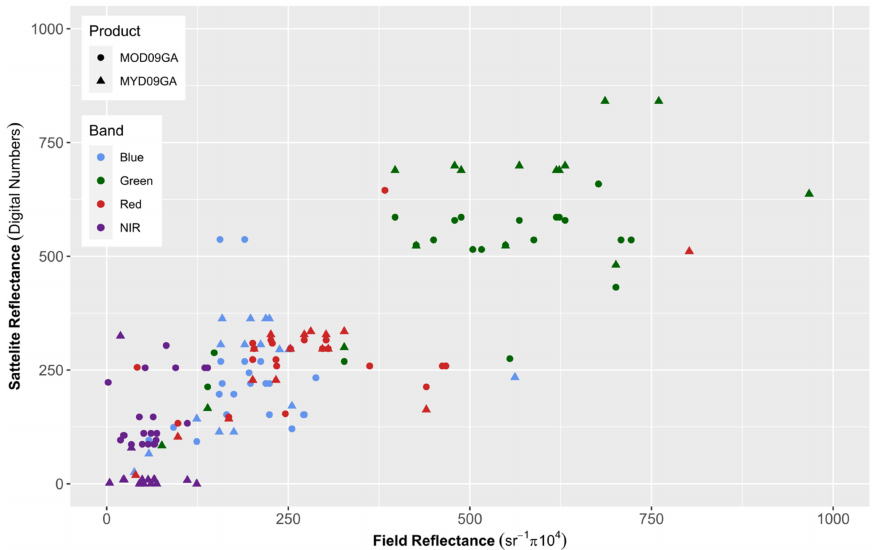
Figure 2. Reflectance that was extracted from subsets of MODIS products MOD09GA and MYD09GA compared to the reflectance that was measured in the field at the same day (78 images, r 2 = 0.67). The field reflectance data was collected with hyperspectral radiometers and used to simulate the MODIS bands 1 (red), 2 (near infrared), 3 (blue), and 4